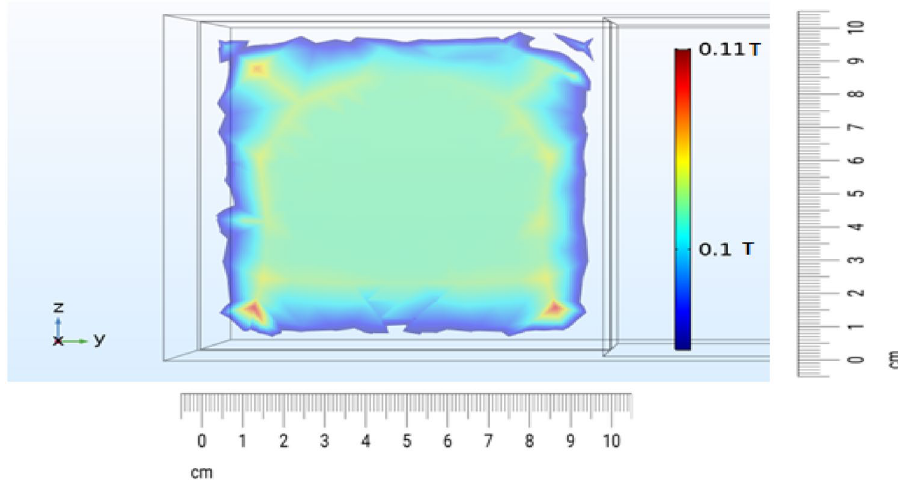
Figure 4. Simulation of the magnetic field intensity within the air gap intersection square with the size of 10 × 10 cm 2 using COMSOL software.